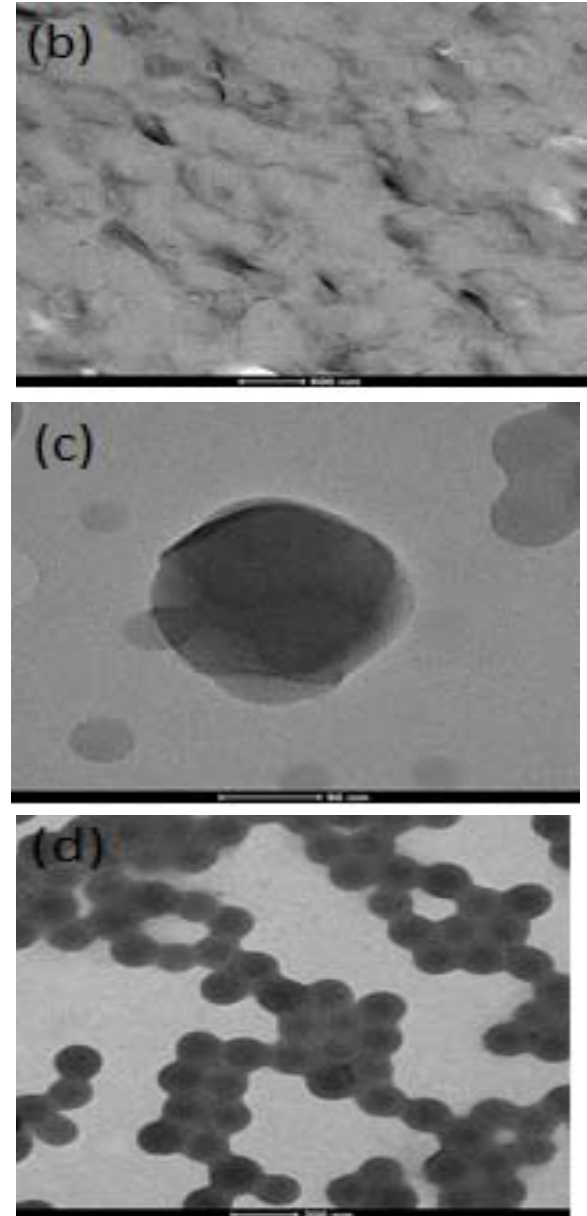
Fig. 9. TEM micrographs for all: (a) 14 down, (b) 14 up (c) 28 film powdered and (d) 28 film. By increasing the clay content up to 10 wt%, both WVTR and OTR decreased compared to sample containing 7 wt% clay. On the other hand, degree of exfoliation has been decreased [1,